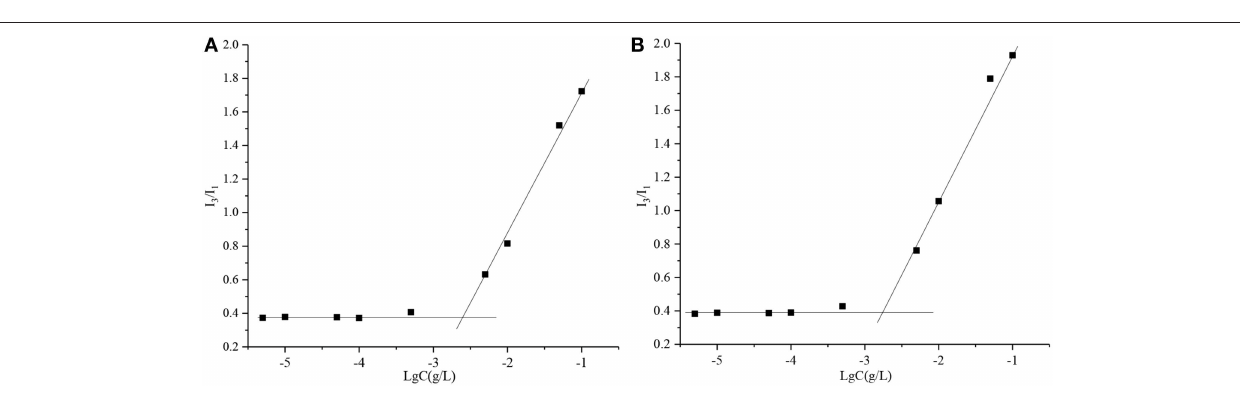
FIGURE 2 | The CMC of PPSP (A) and PPCP (B)